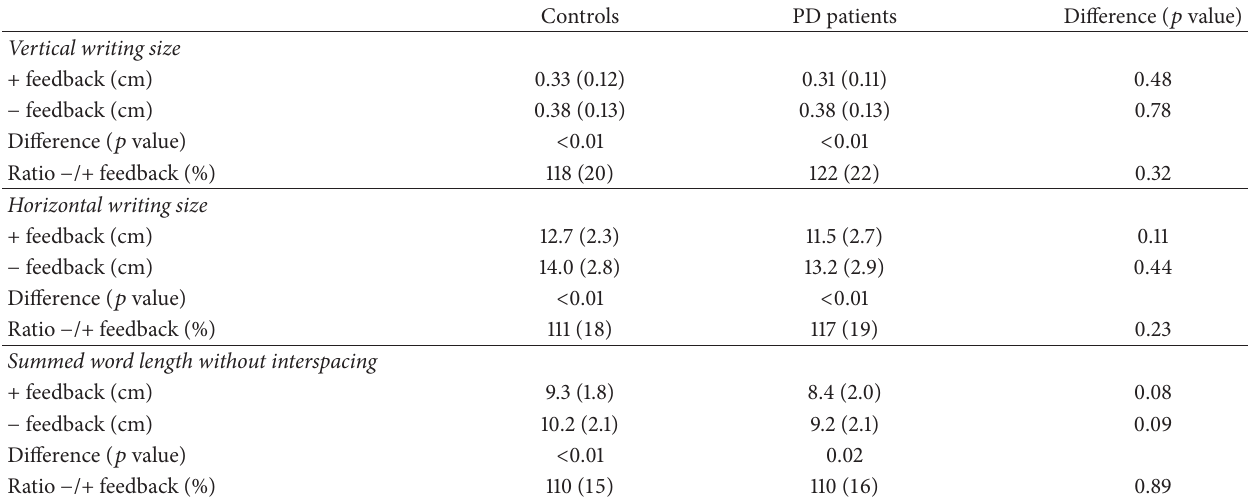
Table 2: Size of writing in the presence and absence of visual